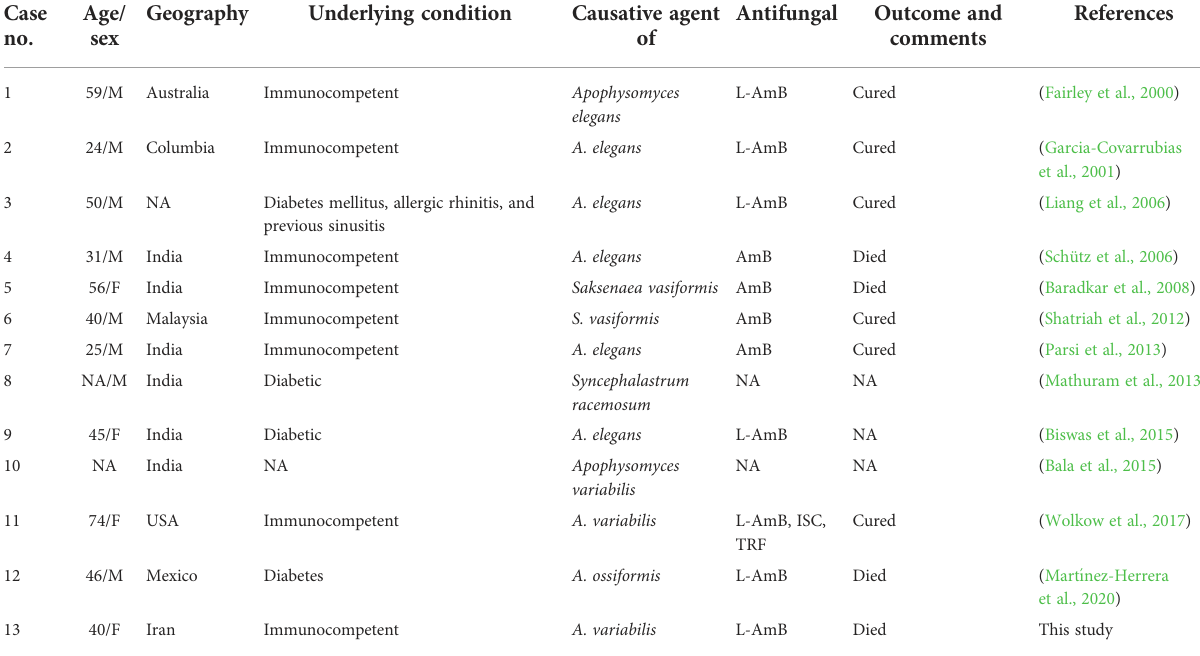
TABLE 1 Clinical characteristics, treatment, and outcomes of patients with rhino-orbito-cerebral mucormycosis caused by rare or unusual species of Mucorales. Case